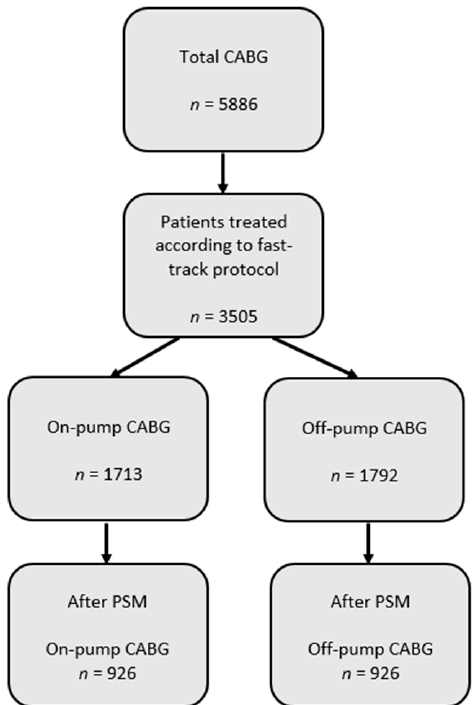
Figure 2. Patients flowchart. CABG = coronary artery bypass grafting; PSM = propensity score matching. The patient’s baseline characteristics and operative data were comparable and shown in Table